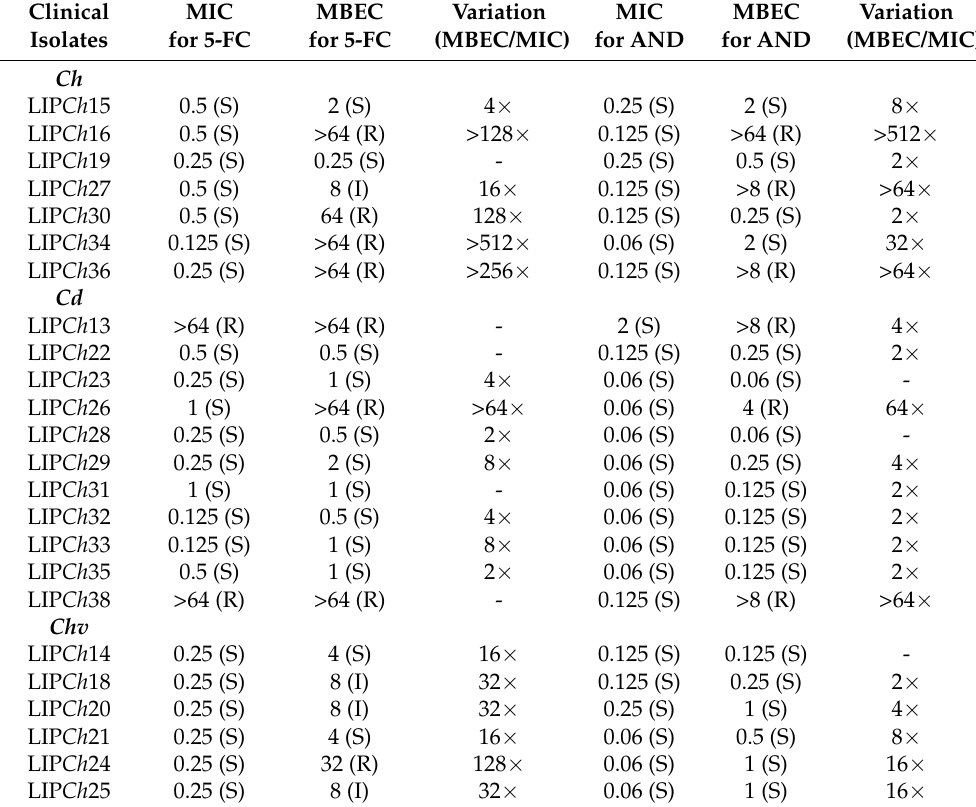
Table 5. Comparison of the susceptibility profile between planktonic- and biofilm-forming cells of the C. haemulonii complex isolates against flucytosine and